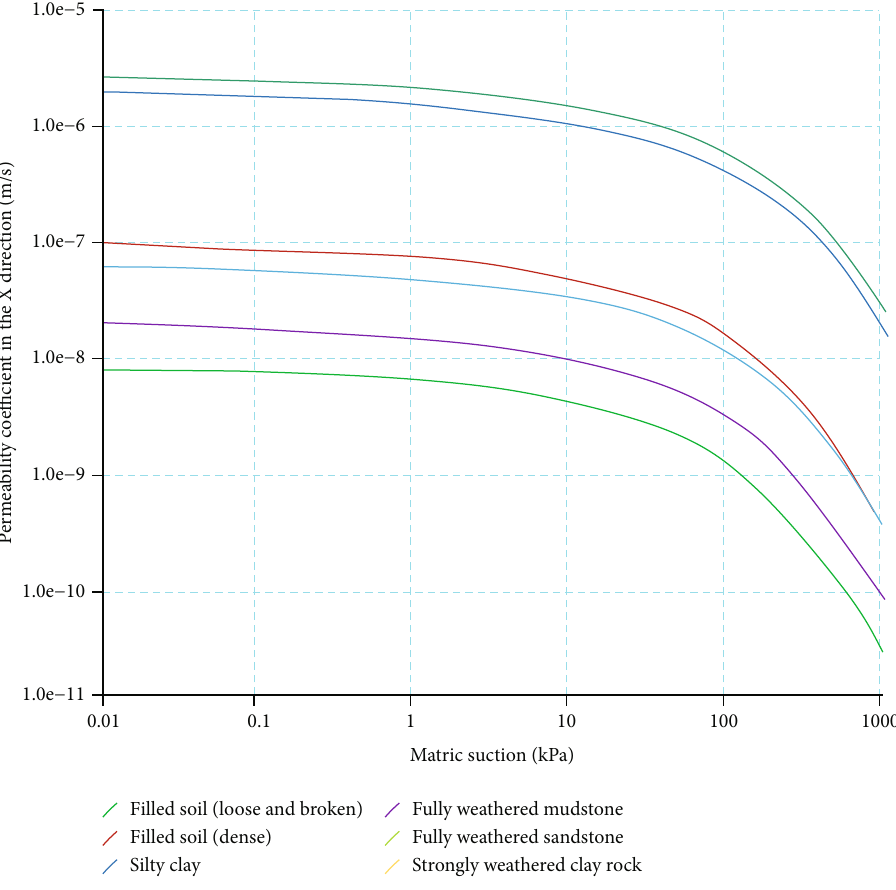
Figure 13: Relationship between unsaturated permeability coe ffi cient and matric suction.